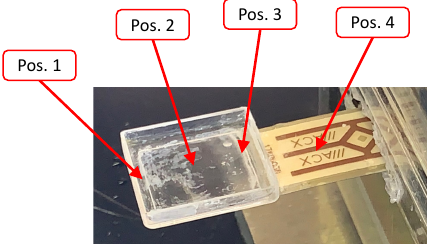
Figure 6. Four impact positions on the harvester.